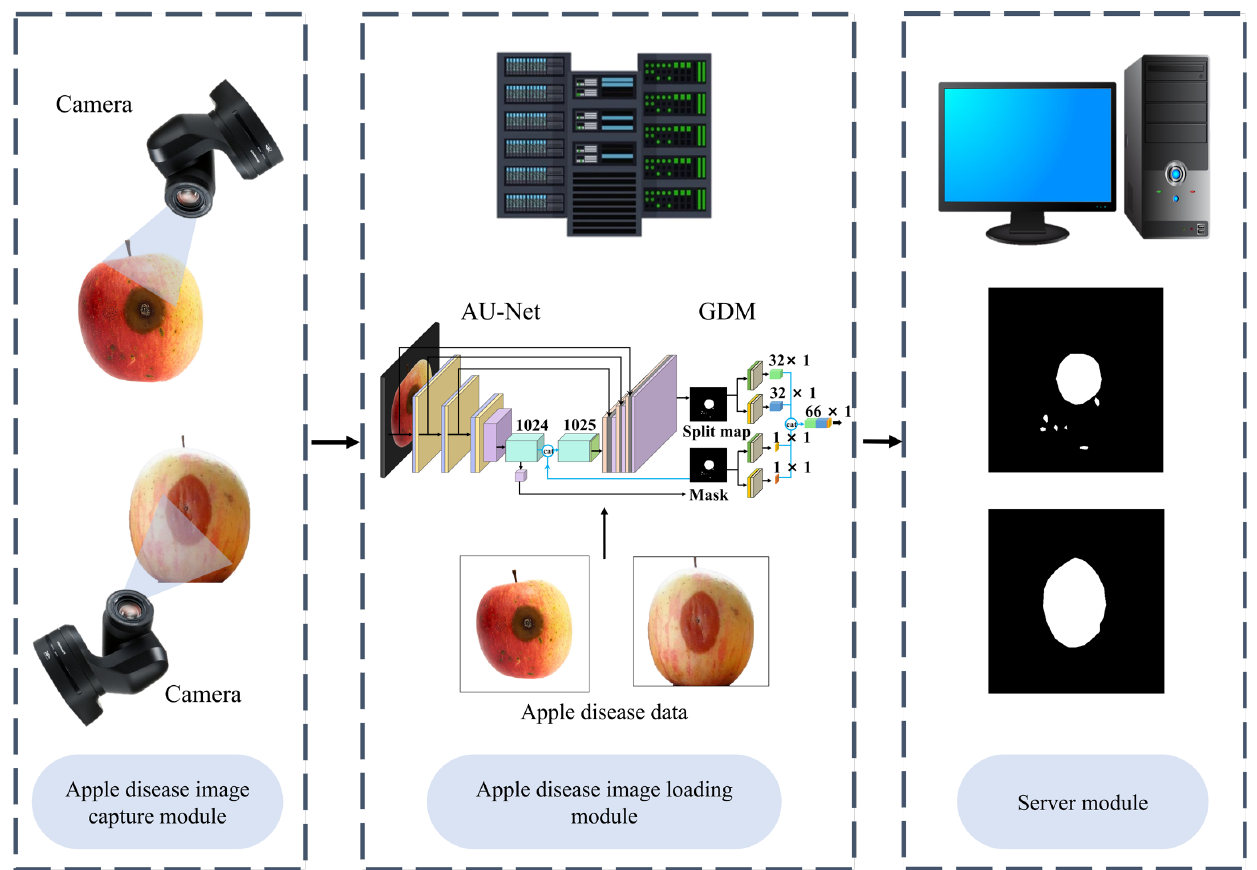
Figure 14. Apple surface defect detection system diagram.